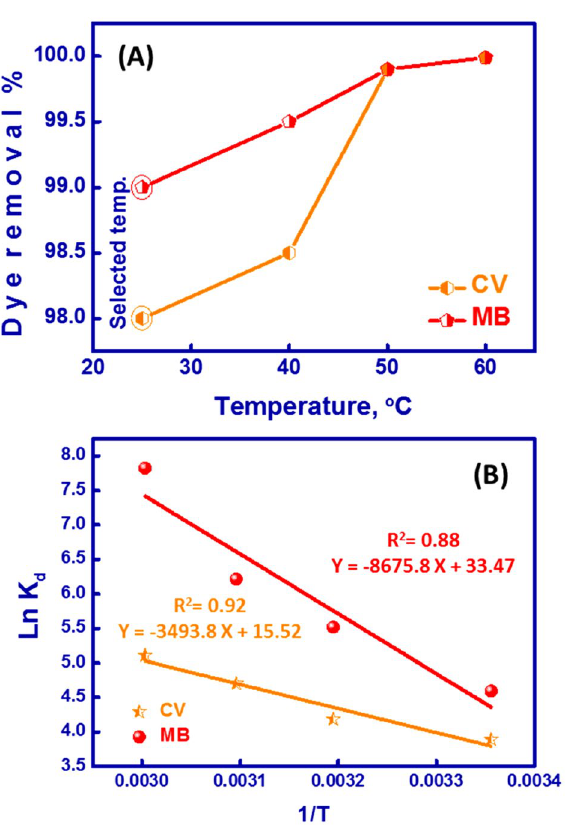
Figure 6. ( A ) Impact of temperature on the MB&CV-removal %, and ( B ) a curve of lnK d vs 1/T to determine of ΔG ° , ΔS ° , and ΔH ° of MB and CV adsorption using